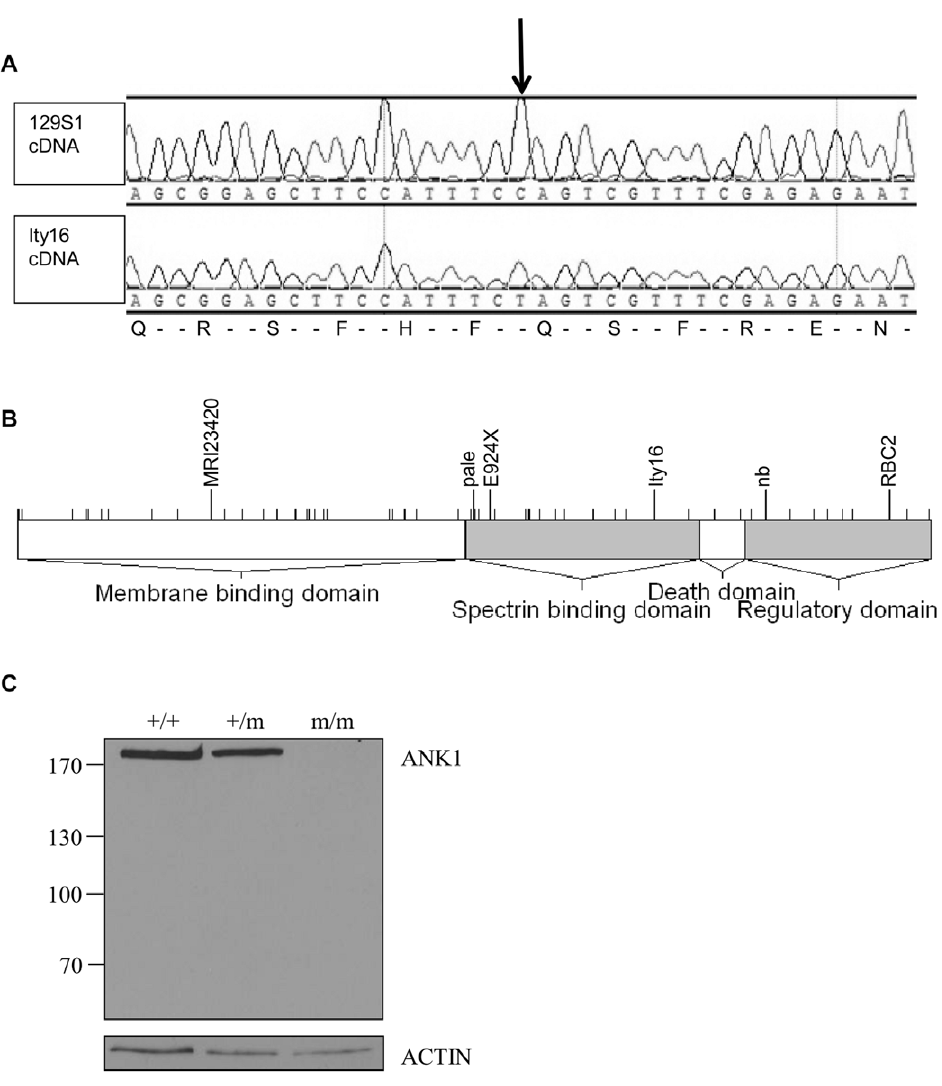
Figure 3. Ity16 mutant mice carry mutation within the Ank1 gene. A) A C to T transition (arrow) at cDNA position 4069 (c.4069C . T) resulting in a stop codon at amino acid position 1357 (p.Gln1357Ter) was detected in Ank1 Ity16/Ity16 mutant. The Ity16 mutation is located in exon 33 using the exon numbering of the Ank1 transcript ID ENSMUST00000121802 (Ensembl build 37). B) Schematic representation of the different domains of ANK1 (adapted from [57]) and location of mutations previously identified in human (small ticks) [18] and mouse ANK1 [13,14,15,16,17]. The Ity16 allele is shown together with two spontaneous ANK1 recessive mutations ( nb and pale ) and three dominant mutants ( RBC2 , M1Wlst and MRI23420 ). C) Immunoblot of RBC ghosts prepared from wild-type ( + / + ), heterozygous ( + /m) and mutant Ank1 (m/m) littermates probes with ANK1 antibody. The size of the molecular markers in kDa are shown on the left. An expected band of about 210 kDa was observed in samples from the wild-type and heterozygous mice while this band or any smaller bands corresponding to a truncated version of the protein could not be detected in mutant